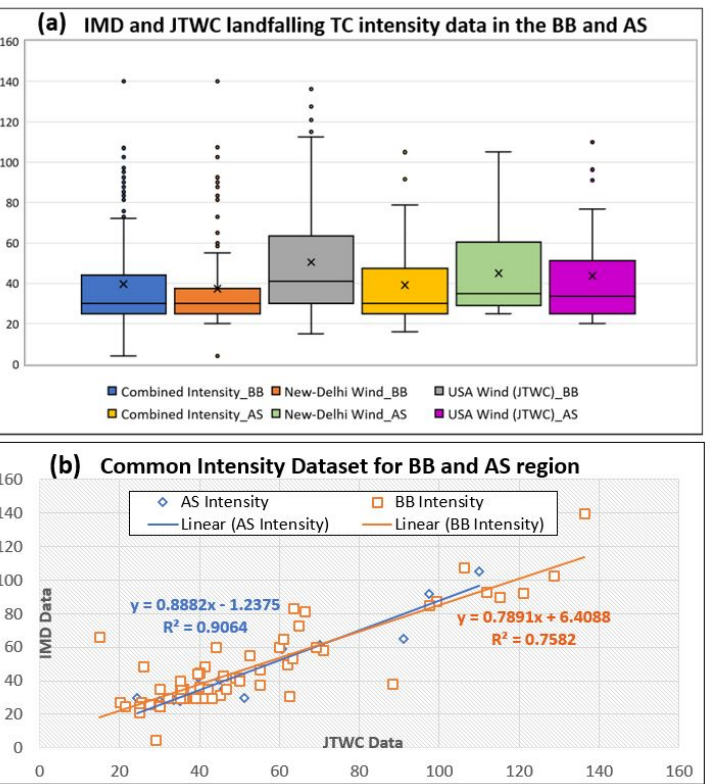
Figure 2. ( a ) Intensity data for the Bay of Bengal (BB) and the Arabian Sea (AS) region using the Indian Meteorological Department (BB-orange, AS-green), Joint Typhoon Warning Center (BB-grey, AS-magenta), and the Common dataset (BB-blue, AS-gold); and ( b ) linear regression and r-squared values for the Common Intensity Dataset for the BB (blue) and AS (orange) regions. In panel ( a ) the mean is indicated by “x” and outlier points are indicated by filled circles.